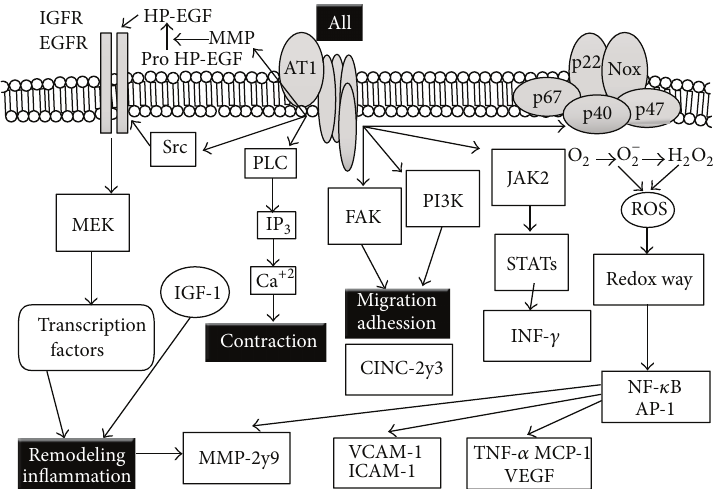
Figure 3: Associated intracellular cascades to physiopathology of vascular remodeling. In FFHR experimental model, the route associated with the satellite receptor and the IGFR subunit associated with NAD(P)H oxidase are the most important pathophysiological mechanisms. Also, the oxidative stress pathway stimulated by angiotensin activates redox-sensitive inflammatory molecules such as AP-1 and NF- 𝜅 B, which amplify vascular inflammatory